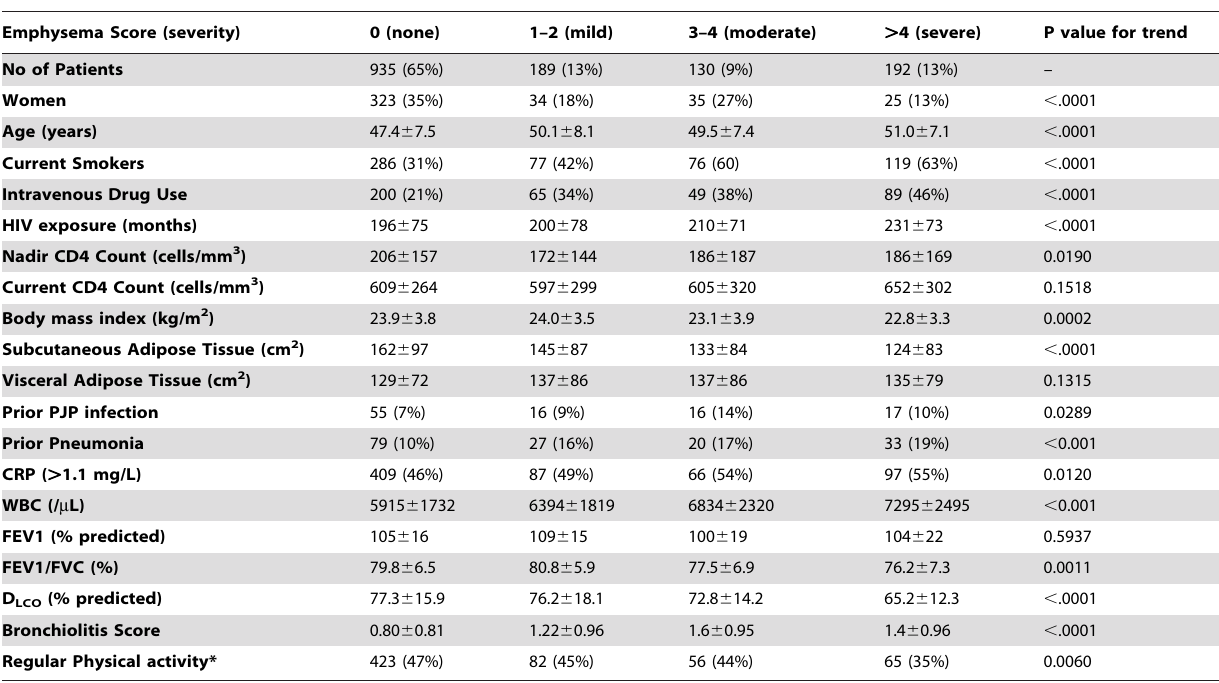
Table 2. Clinical Risk Factors and Health Outcomes for